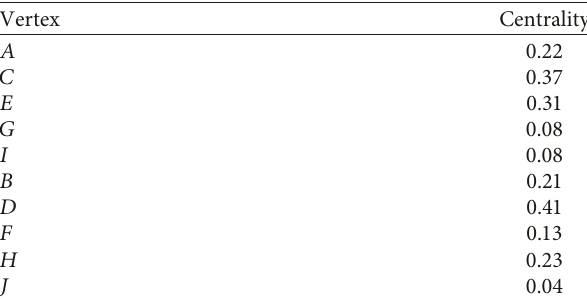
Table 7: Centrality of all vertices of Figure